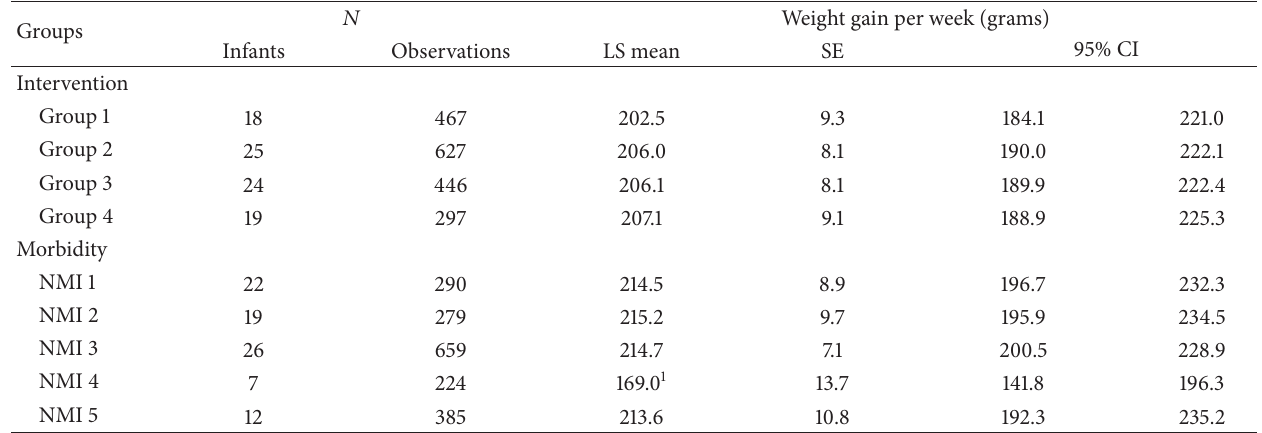
Table 4: Weight gain during oral